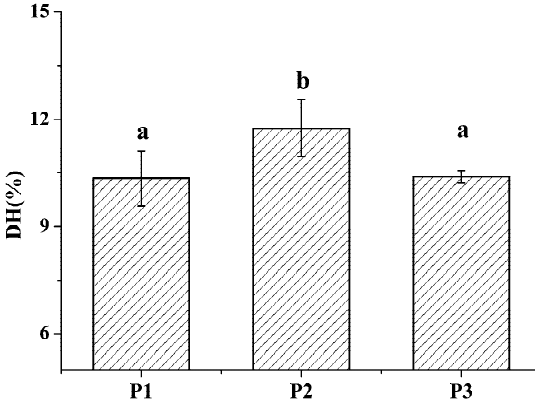
Figure 1. SDS-PAGE analysis of different-solubility protein fractions from M. edulis was shown . P1: proteins extracted in 0.05 M PBS (pH 7); P2: proteins extracted in 0.1 M PBS (pH 7) containing 0.6 M NaCl; P3: proteins extracted in 3% ( w / v ) citric acid solution, with heating. LM: Premixed Protein Marker (Low, 14.3–97.2 kDa); HM: Premixed Protein Marker (High, 44.3–200.0 kDa).